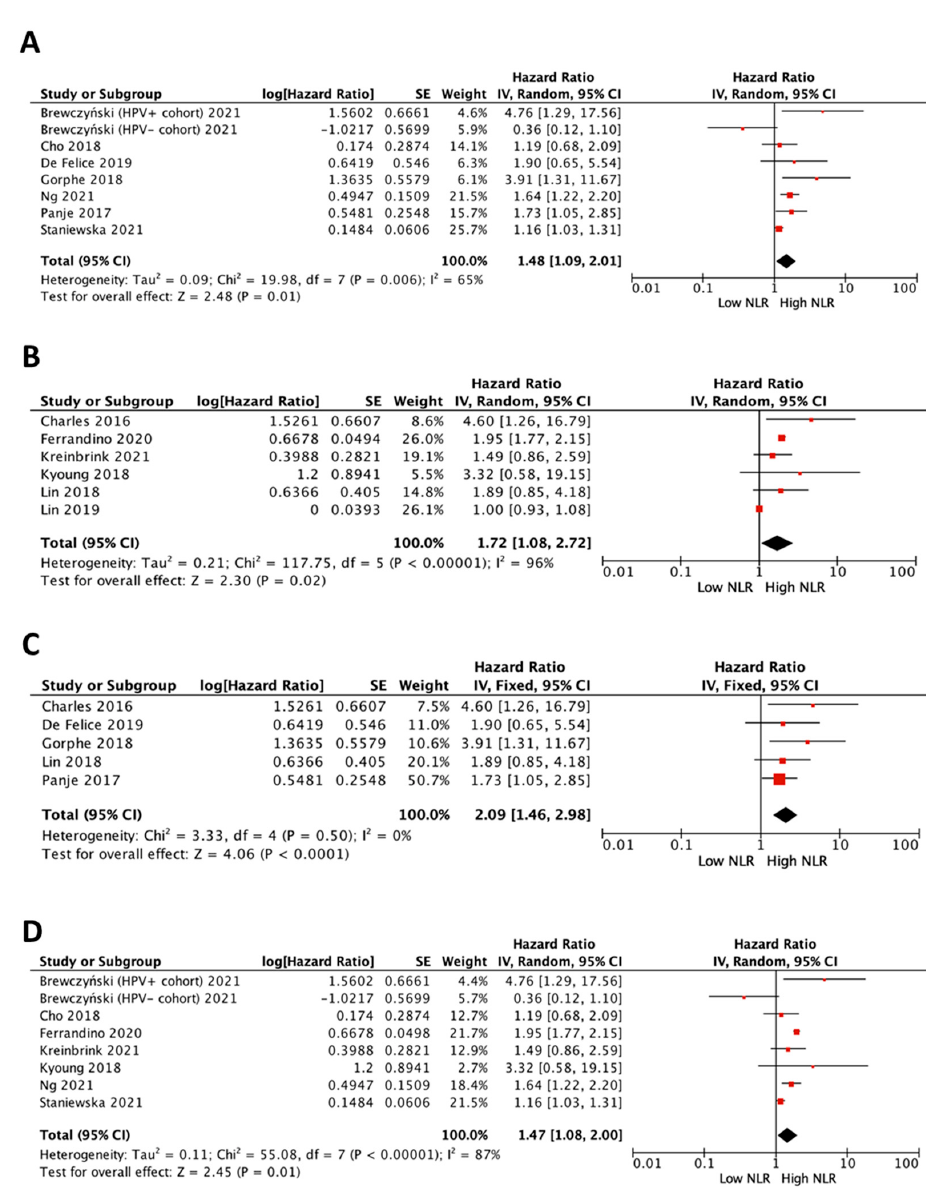
Figure 4. Forest plots of impact of NLR in “all patients” on overall survival with radiotherapy or chemoradiotherapy treatment ( A ) and mixed primary treatment ( B ), and in patients in the group of NLR cut-off ≥ 3.6 ( C ) and NLR cut-off <3.6 ( D ). [13-21, 23-26].